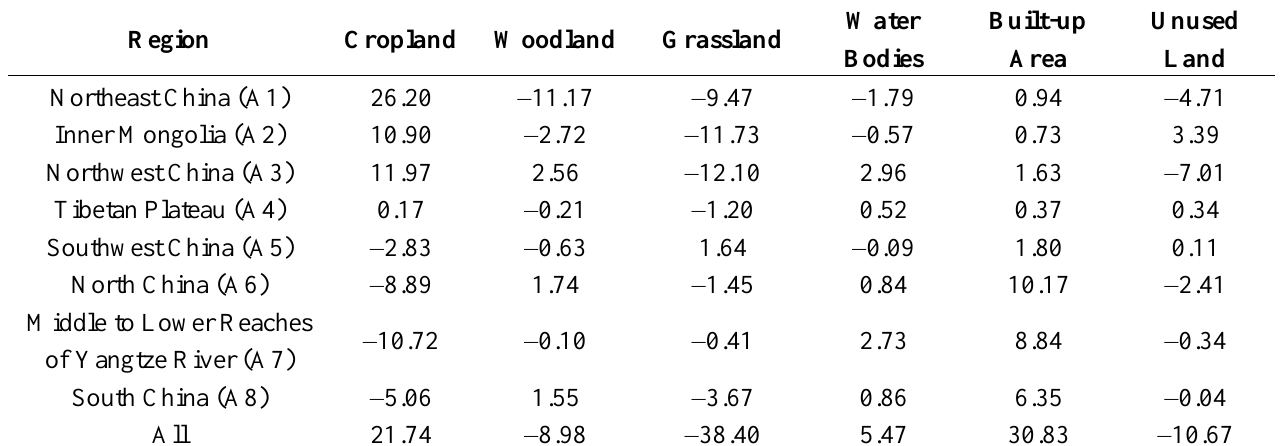
Table 5. Land-use change from 1990 to 2005 (10 3 km 2